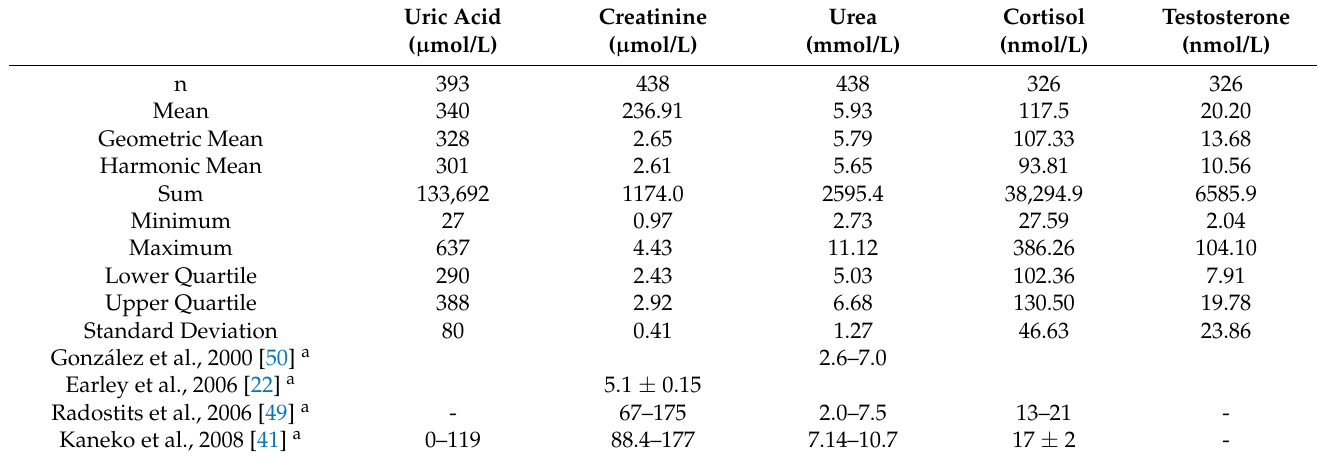
Table 2. Summary statistics of biochemical variables (II) in Lidia bulls’ plasma. Values found by other authors are also shown, both in Lidia breed and in other